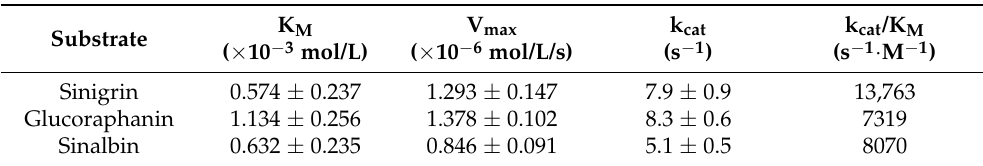
Table 2. Kinetic parameters of the L. sativum myrosinase for hydrolysis of the different glucosinolate substrates assayed with the GOP method.